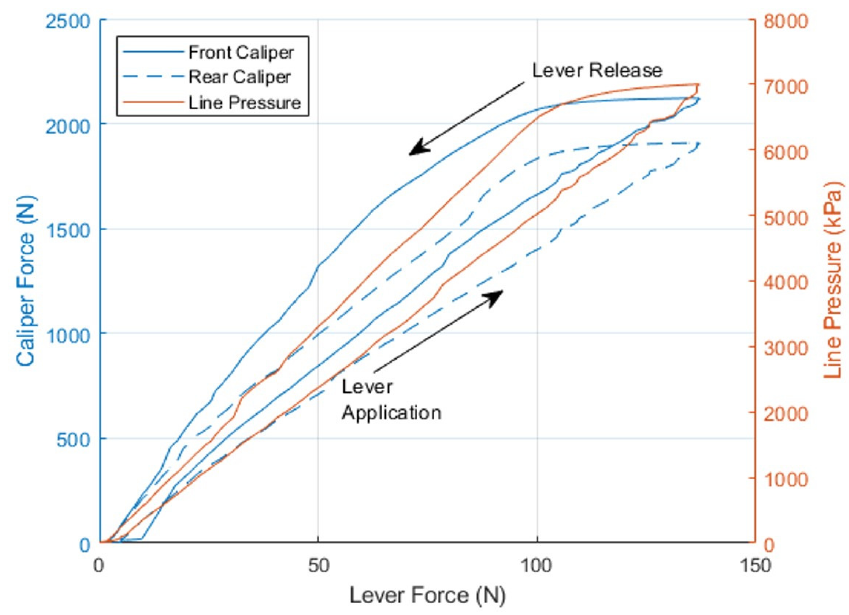
Figure A4. Caliper force and line pressure as a function of lever force. The arrows show the direction of the hysteresis loop.